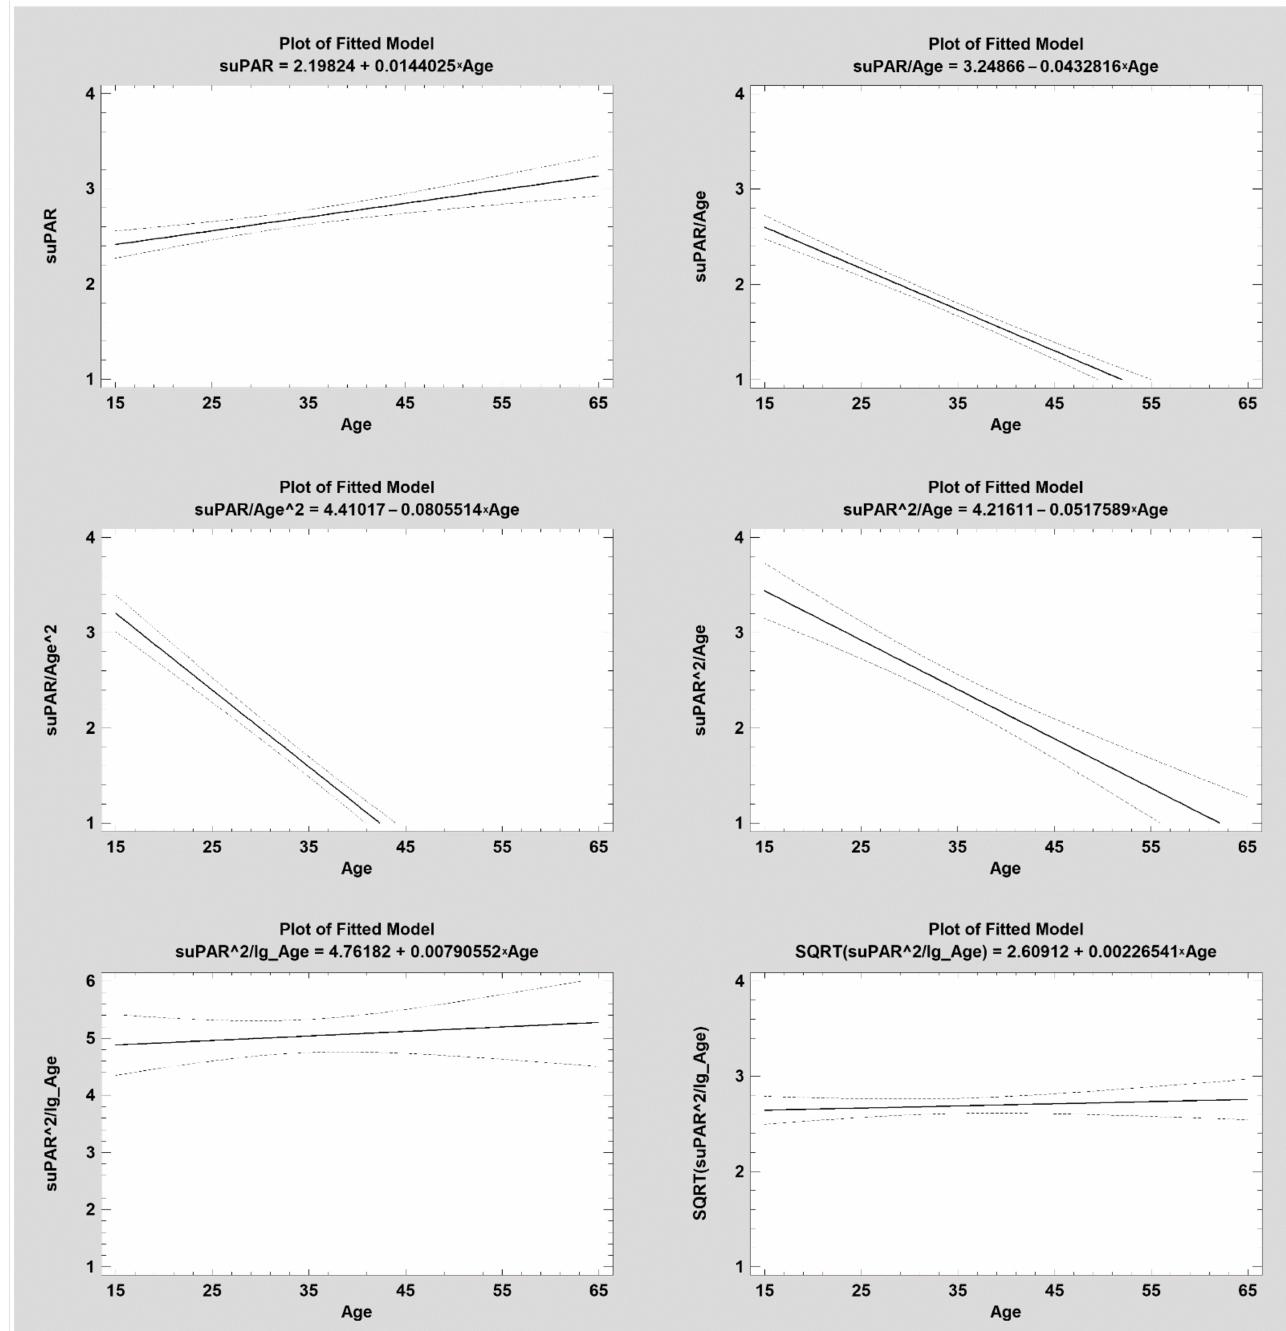
Figure 2. Relation of the soluble urokinase-type plasminogen activator receptor (suPAR, ng/mL) and calculated indeces to patient’s age. Simple regression of suPAR raw data and patient age (top, left-hand side). Dash line describes confidence limits at level of 95%. The level of suPAR gradually and significant increases in time (years). The both lowest plots confirm age independence and only lower right-hand belongs normal distribution. Moreover, range of value SQRTsuPARˆ2/lg_Age is similar to raw data range. Note: The calculations were based on indeces calculated according to the Equations